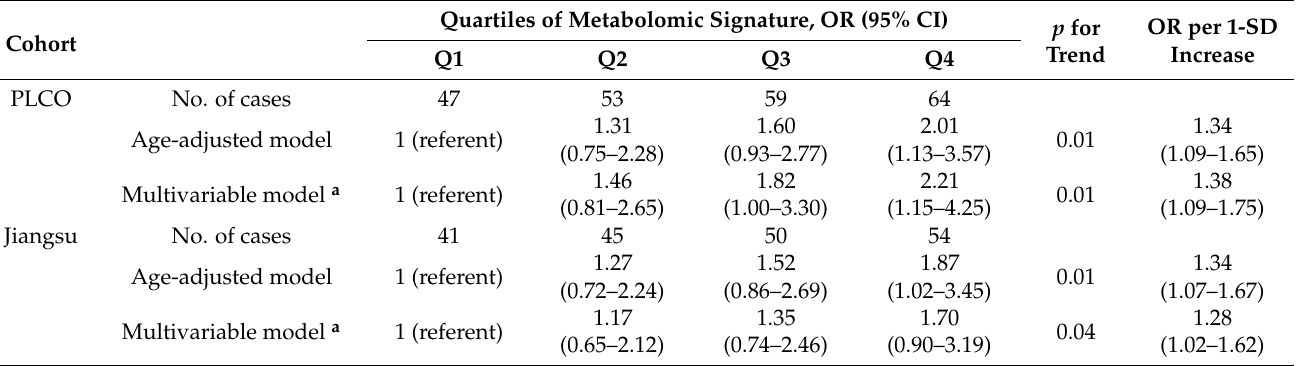
Figure 2. Dose–response association between the metabolomic signature of body mass index and colorectal cancer risk in the PLCO ( A ) and Jiangsu ( B ) cohorts. The association was examined by the multivariable conditional logistic model with restricted cubic splines. Solid lines represent estimates of odds ratio, and dashed lines represent 95% confidence intervals ( p for linear = 0.01 in the PLCO; p for linear = 0.03 in the Jiangsu cohort). The metabolomic signature above 95% was not plotted due to wide confidence intervals at the extremes. Abbreviations: PLCO, Prostate, Lung, Colorectal, and Ovarian Cancer Screening Trial. Table 2. Association between the metabolomic signature of obesity and colorectal cancer risk in the PLCO and Jiangsu cohorts.